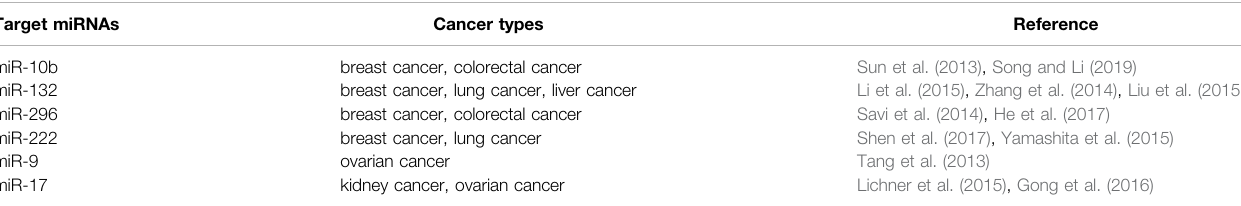
TABLE 3 | Inhibition of overexpressed miRNAs in